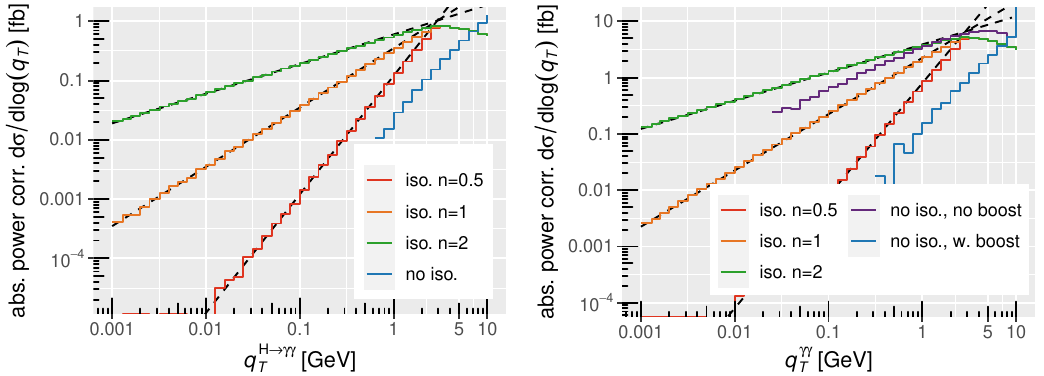
> 25 GeV on both photons. T